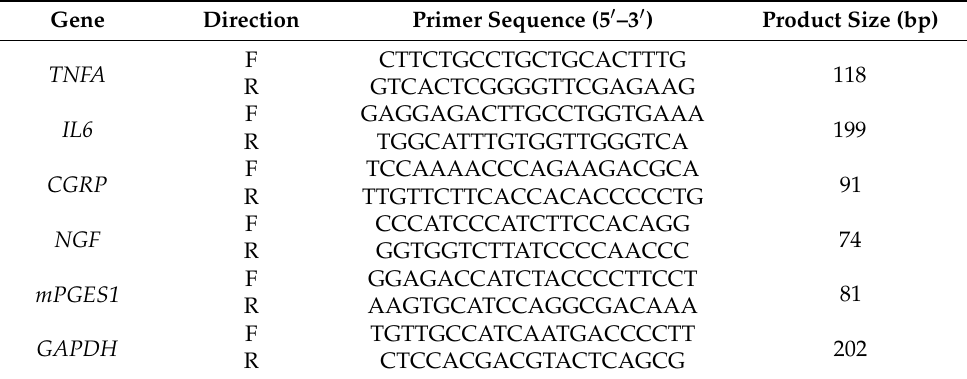
Table 5. Sequences of primers used in this